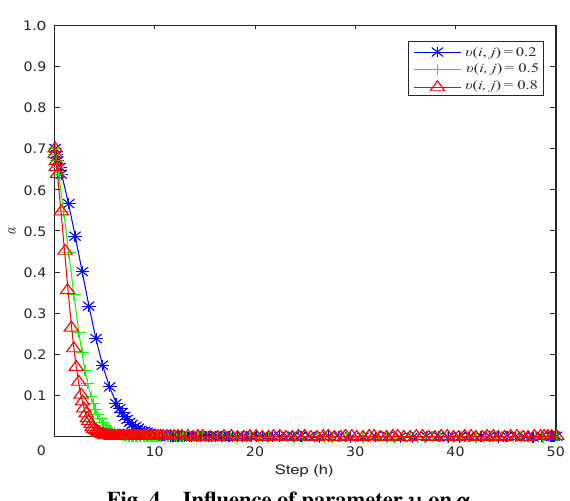
Fig. 4 Influence of parameter (cid:29)(cid:29)(cid:29) on ˛˛˛ .